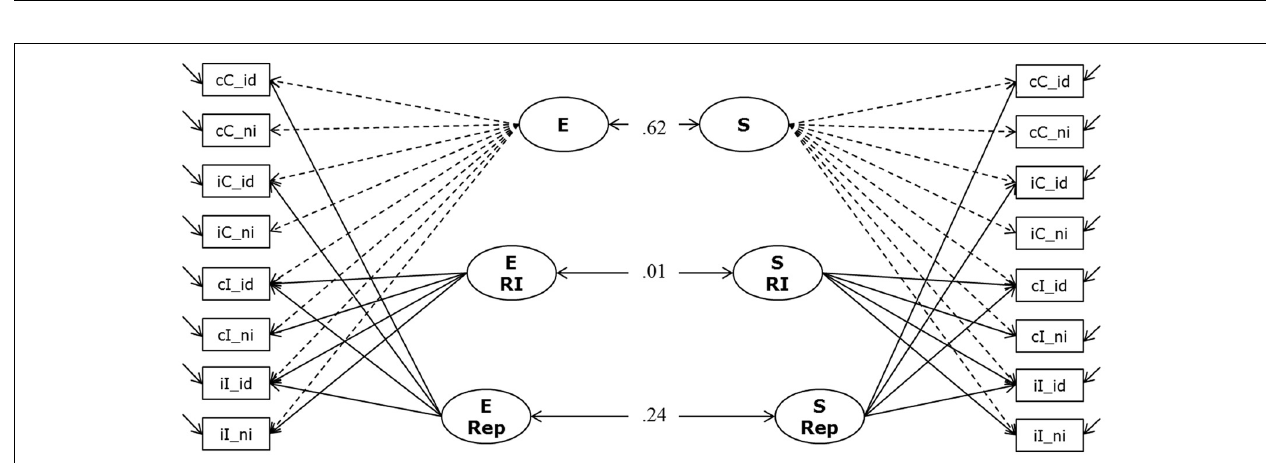
(Cspan). The VN (Verbal-Numerical Content) factor is maintained from Model 2. SM, Secondary Memory; PAsso, Learning Paired-Associations; _v, verbal indicators; _n, numerical indicators; _f, figural indicators; _lc, letter-color; _wn, word-number; _ll, location-letter; CS, Cspan indicators.